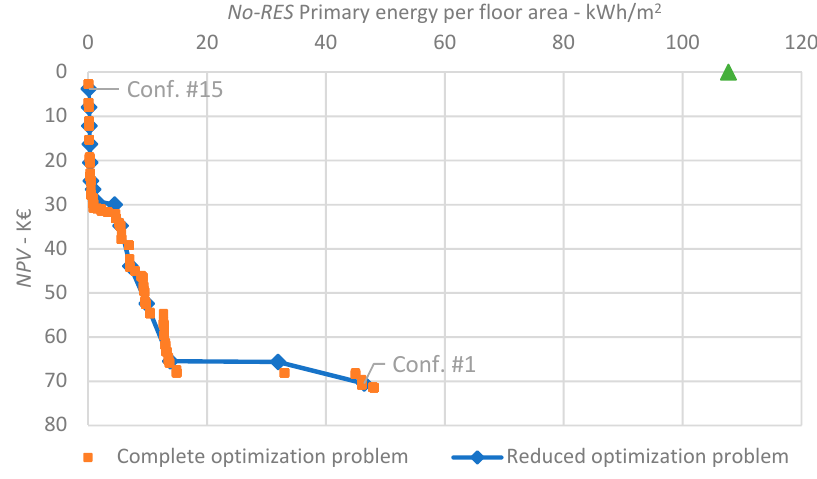
Figure 3. Pareto frontiers of the full (477 points) and reduced (15 points) optimization problems. The No-RES configuration is shown with a green marker.